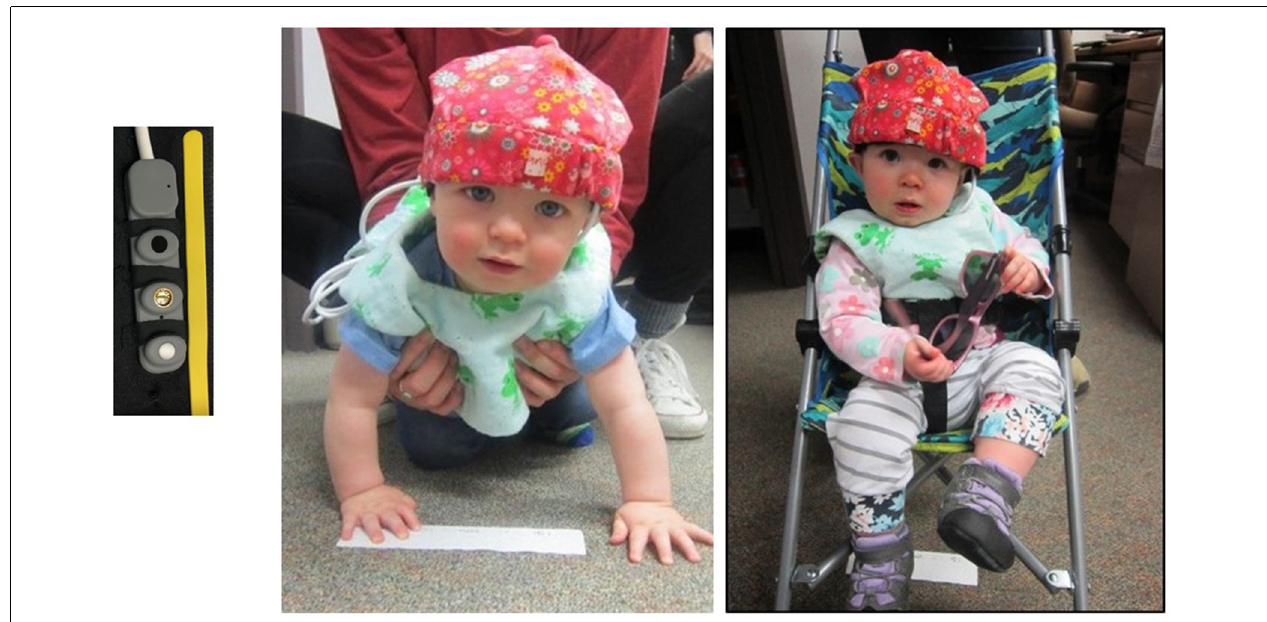
FIGURE 1 | Pediatric sensor strip and infants in the crawling and stroller